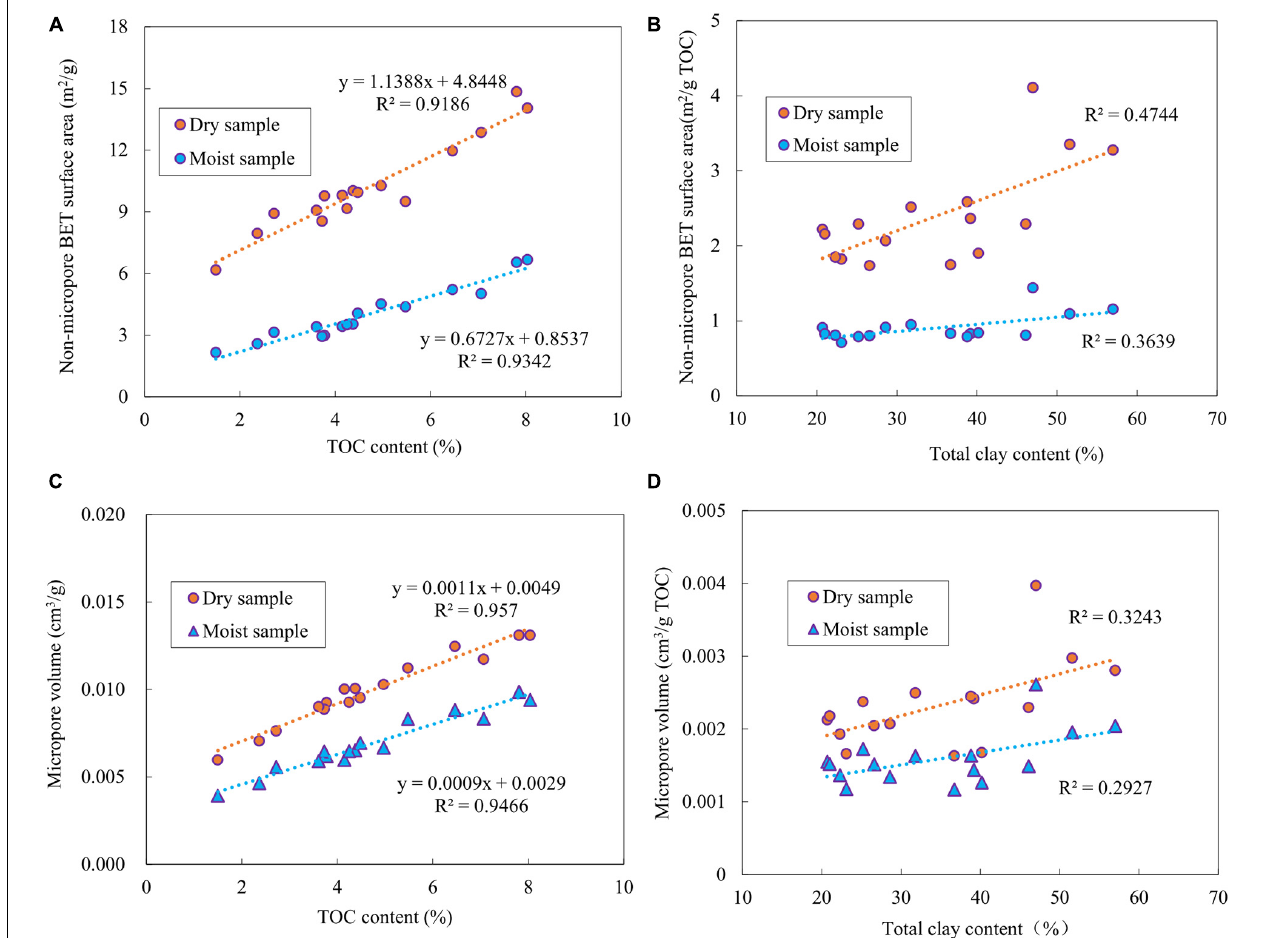
FIGURE 6 | The correlations of S BET (A,B) and V mic (C,D) with TOC and clay minerals.